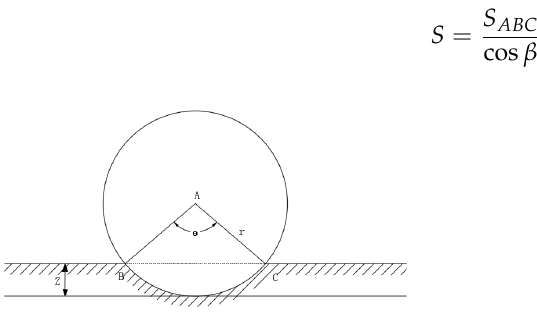
Figure 6. Schematic diagram of the effective area of the disc grounding.